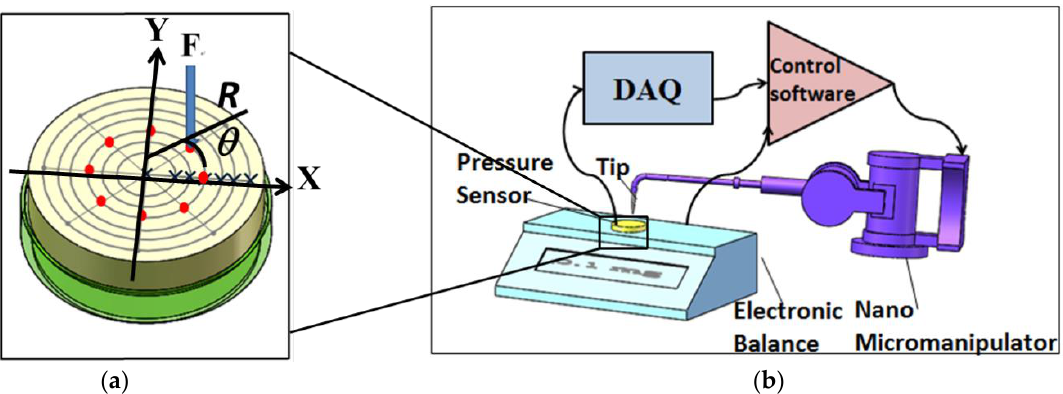
Figure 5. ( a ) Schematic of the contact force acting on the pressure sensor’s diaphragm. ( b ) Schematic of the experimental system.